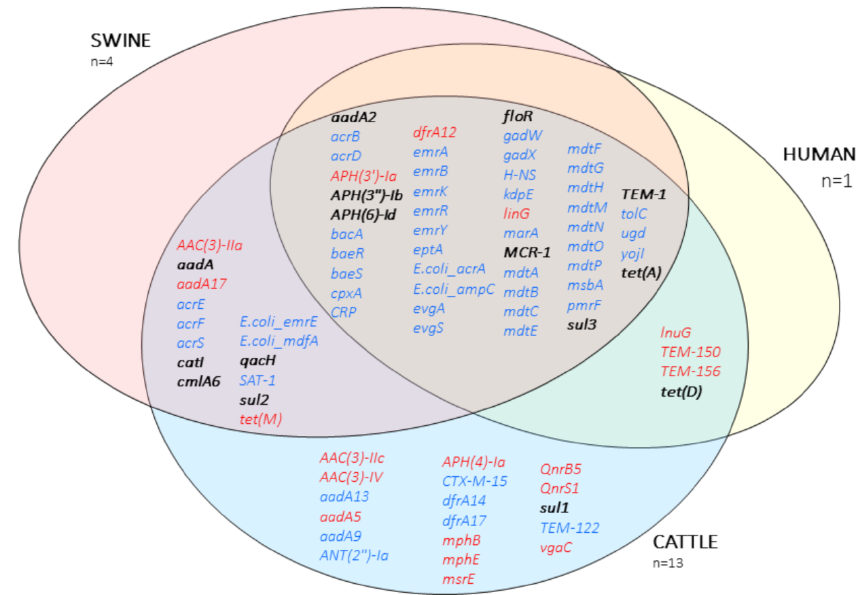
Figure 3. Venn diagram of the antibiotic resistance genes described in this study. Text in blue, chromosomal location; text in red, plasmid location; bold, located either in the chromosome or